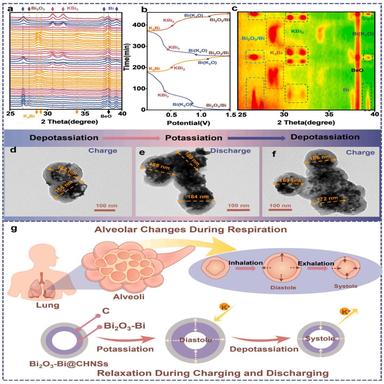
a–c) In situ XRD pattern of Bi2O3-Bi@CHNSs electrode. d–f) Ex suit TEM images of Bi2O3-Bi@CHNSs. g) Schematic diagram of Bi2O3-Bi@CHNSs anode systole/diastole during the charging/discharging process inspired by changes during alveolar respiration.